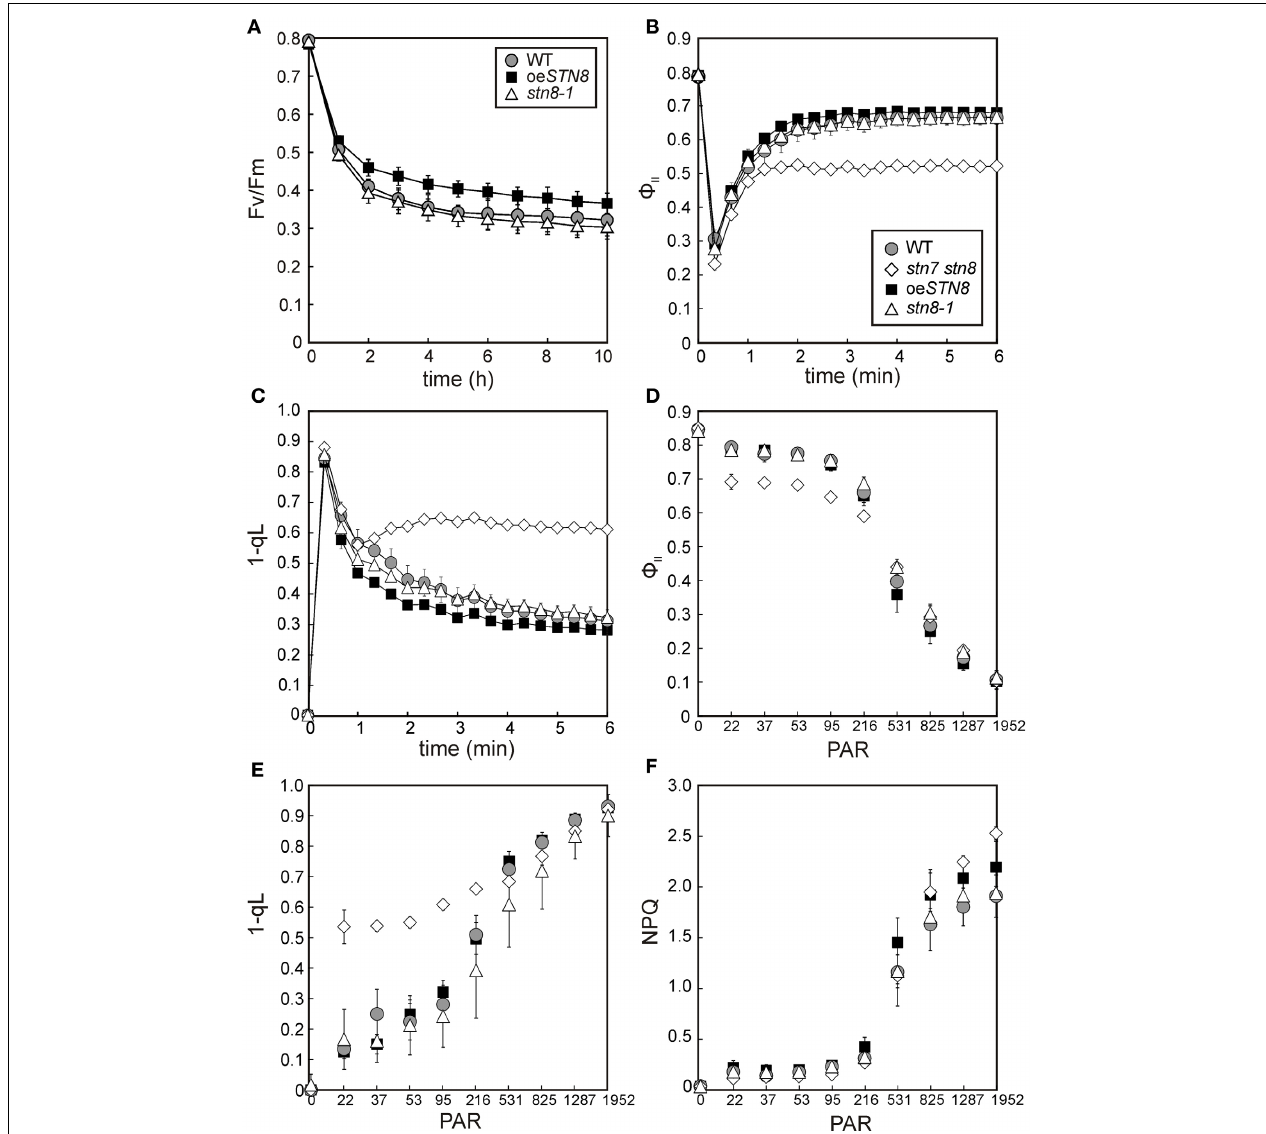
Dependence of Chl a fluorescence on light intensity. The effective quantum yield of PSII ( (cid:3) II ) (D) , the excitation pressure of PSII (1-qL) (E) and non-photochemical quenching of chlorophyll fluorescence (NPQ) (F) were monitored as red light intensity was increased stepwise at 5-min intervals (22, 37, 53, 95, 216, 513, 825, 1,287, and 1,952 μ mol photons m − 2 s − 1 ) after 10min of dark adaptation. PAR, photosynthetically active radiation ( μ mol photons m − 2 s − 1 ); circles with gray filling, WT; squares with black filling, oe STN8 ; triangles; stn8-1 ; diamonds, stn7 stn8 . (A–F) Plants were grown under an 8 h/16h day/night regime at 100 μ mol photons m − 2 s − 1 prior to measurements. Average values ( ± SD) of at least five individual plants are